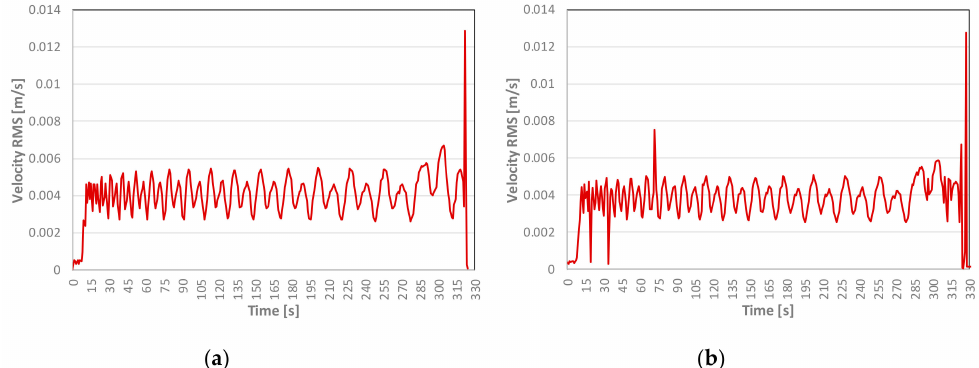
Figure 11. Vibrations amplitude corresponding to CVD TiN / TiCN / Al 2 O 3 coated inserts for two of the machining tests ( a ) PH5740-S1 and ( b ) PH5740-S2 cutting